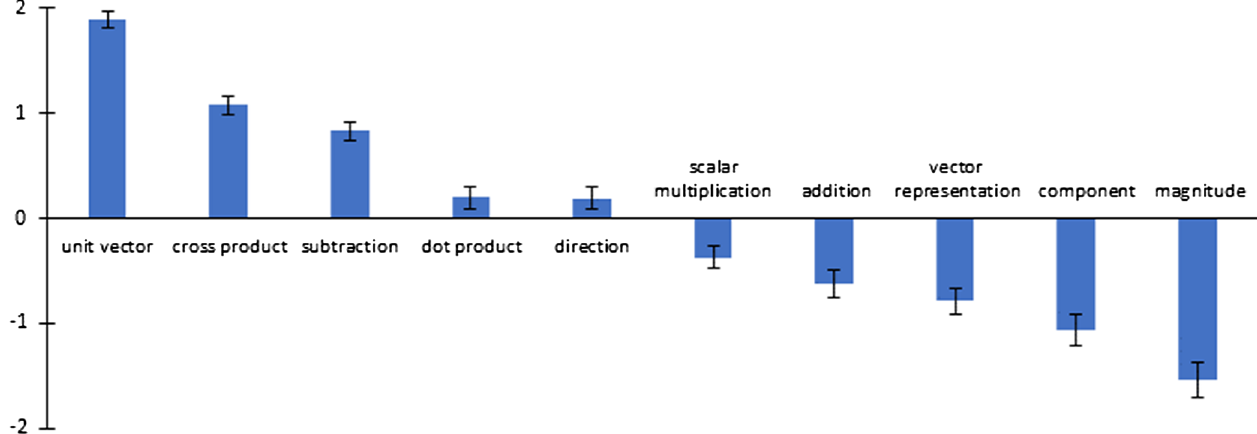
FIG. 2. Average difficulties of the vector concepts, evaluated by the TUV, measured in